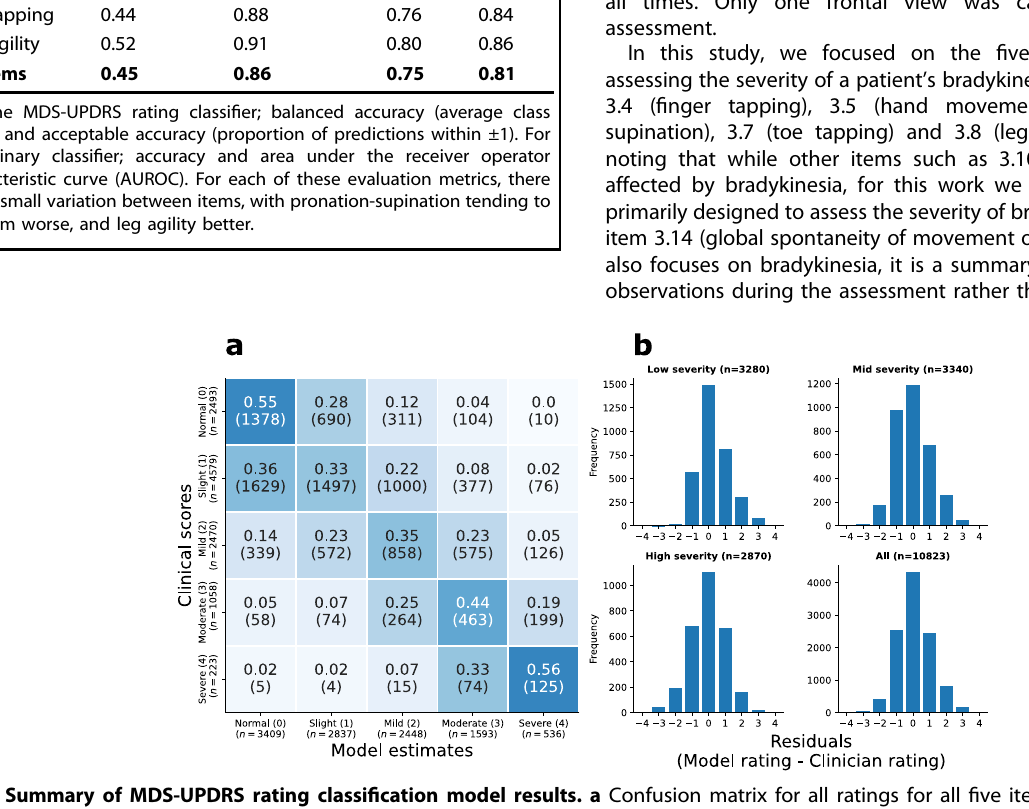
Fig. 4 Summary of MDS-UPDRS rating classi fi cation model results. a Confusion matrix for all ratings for all fi ve items. b Distribution of model residuals, separated by overall disease severity, as measured by the clinical composite bradykinesia score (low ≤ 8; 8 < mid ≤ 15; high > 15). For each of these severity groups, the modal residual was 0 (i.e. exact